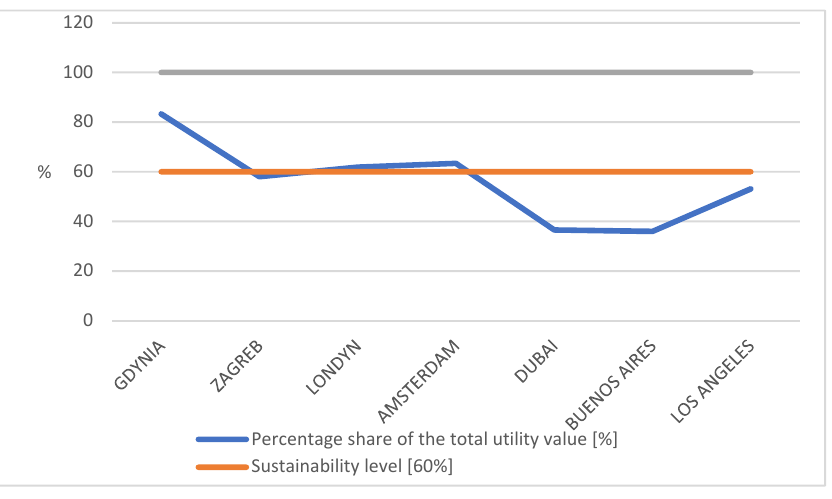
Figure 6. Percentage share of the total utility value with regard to the reference value and sustainability level (60%) for the analysed cities.